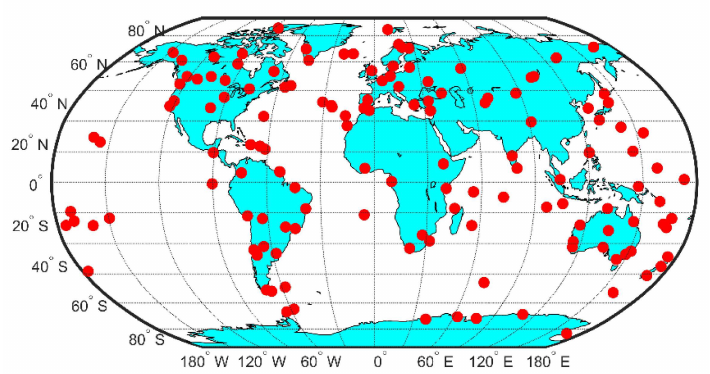
Figure 1. Distribution of the MGEX stations. Table 1. GNSS processing configurations for IFCB estimation and evaluation of triple-frequency PPP.